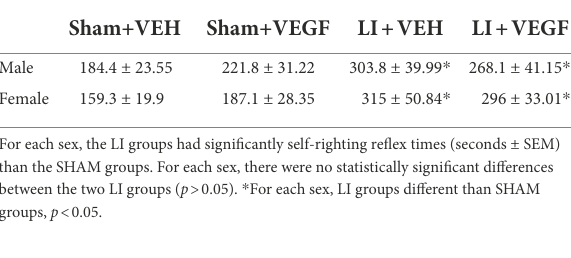
TABLE 1 Acute injury